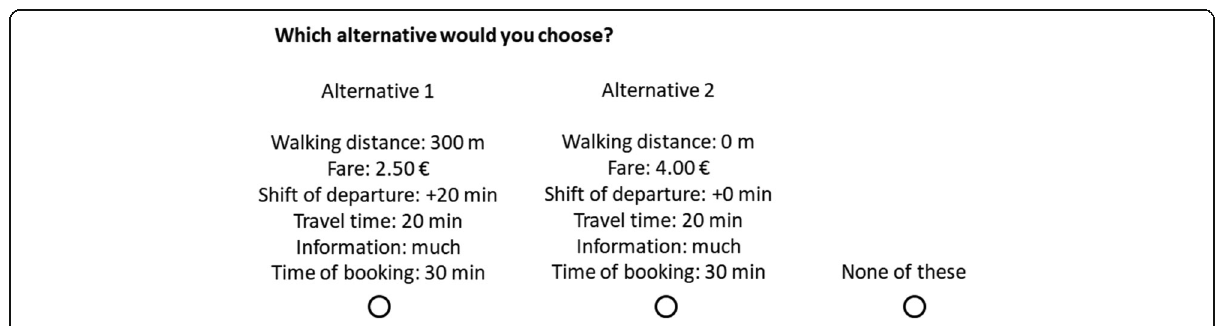
Fig. 1 Example of a choice set of the DCE (translated from